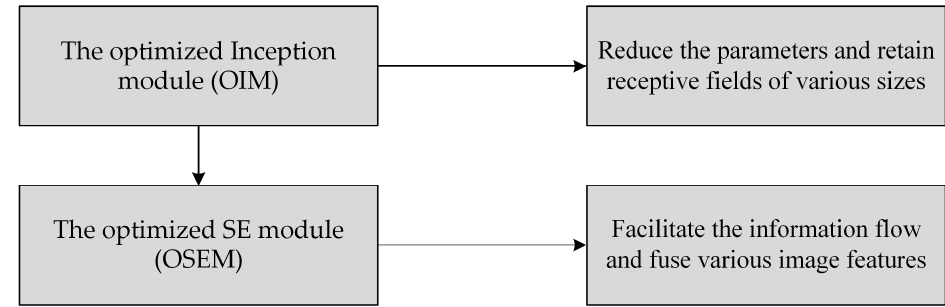
Figure 2. The general schematic flowchart of the transmission line scene classification.